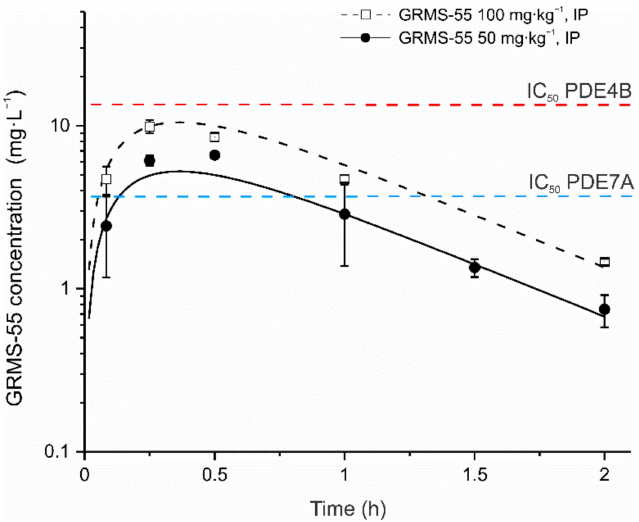
Figure 3. Mean ( ± SD) concentrations of GRMS-55 in the serum of female BALB/c mice following IP administration of this compound at doses of 50 or 100 mg · kg − 1 ( n = 4). Observed concentrations are shown as symbols, and the concentrations predicted by the model are shown as black lines. A blue dashed line indicates the IC 50 value for PDE7A, and a red dashed line indicates IC 50 value for PDE4B that were determined in an in vitro assay using GRMS-55 as a PDE inhibitor and reported in our previous publication